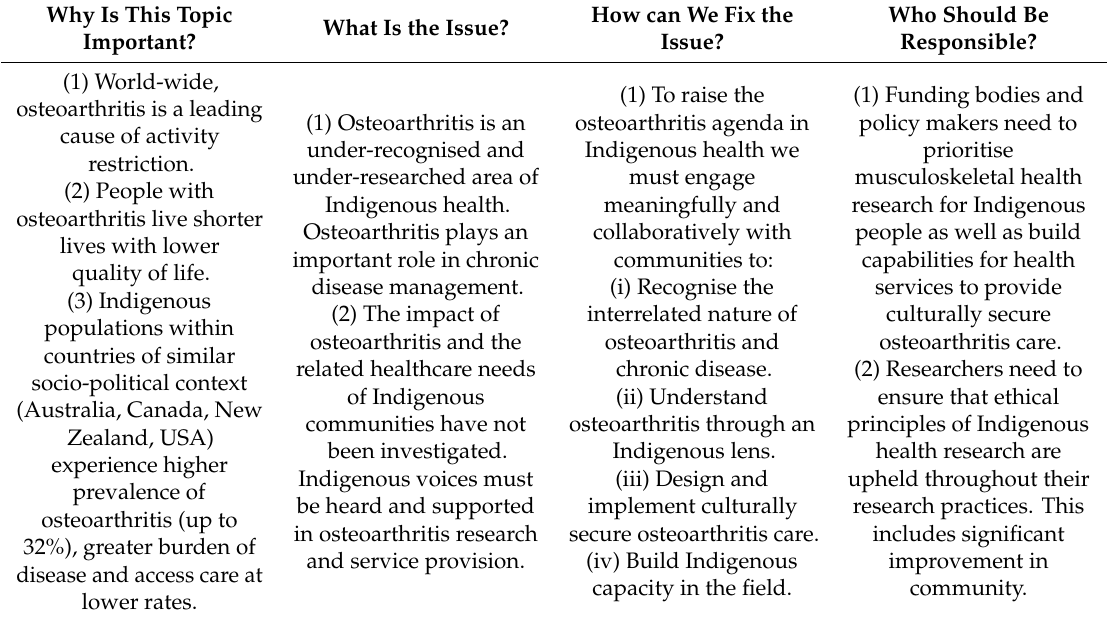
Table 1. Call to Action: Osteoarthritis and Indigenous